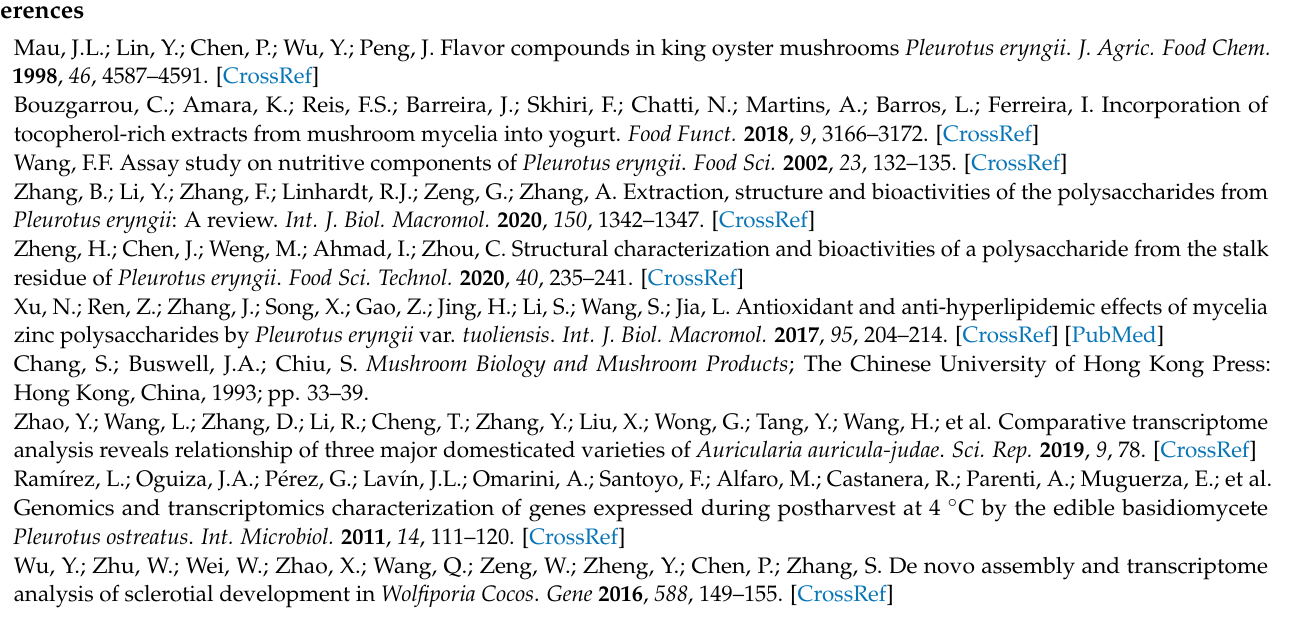
Table S3: KEGG enrichment analysis of